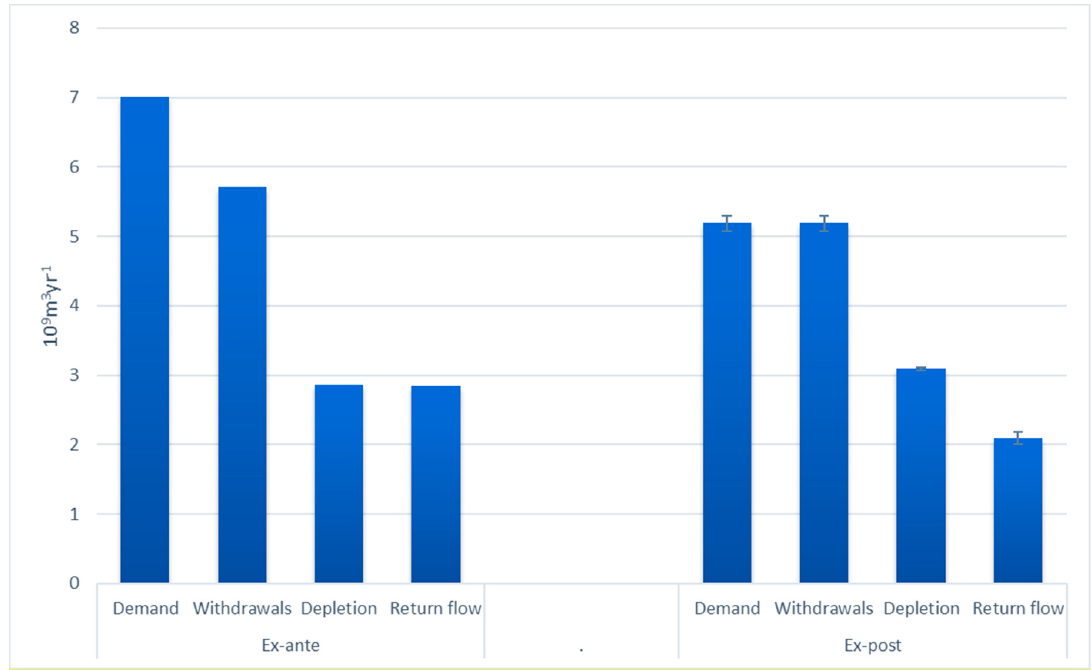
Figure 3. The Urmia Lake Basin ex-ante (2000–2010) and ex-post (2020–2030) Demand, Withdrawals from ground and surface water, Depletion and return flows to the surface and groundwater. The error bars represent the value ranges under the different climate change and socioeconomic.